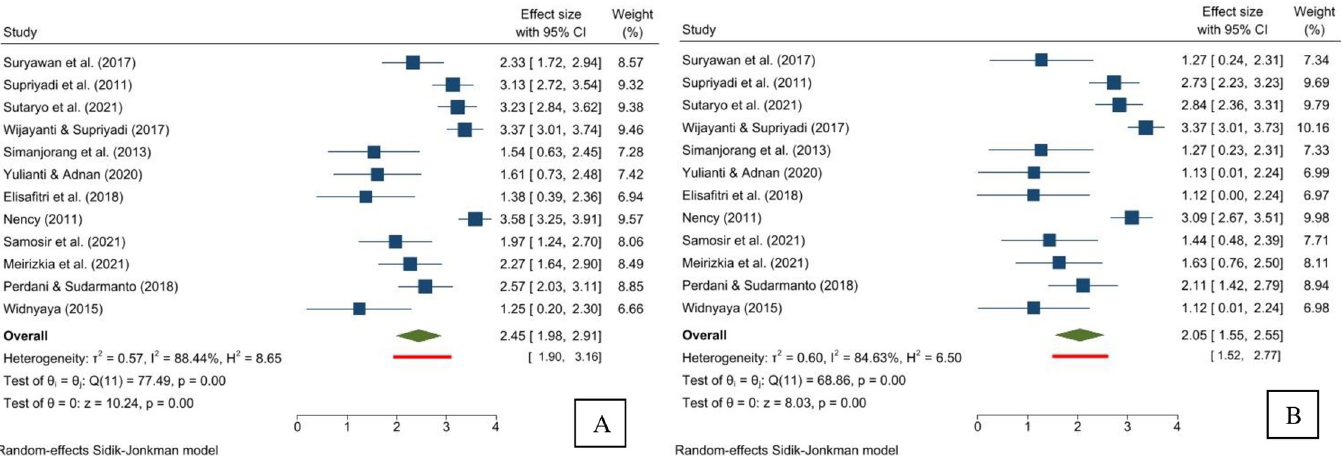
Fig 2. Forest plot showing the incidence rate and prediction interval of childhood acute lymphoblastic leukemia (per 100,000 children) for males (A) and females (B).